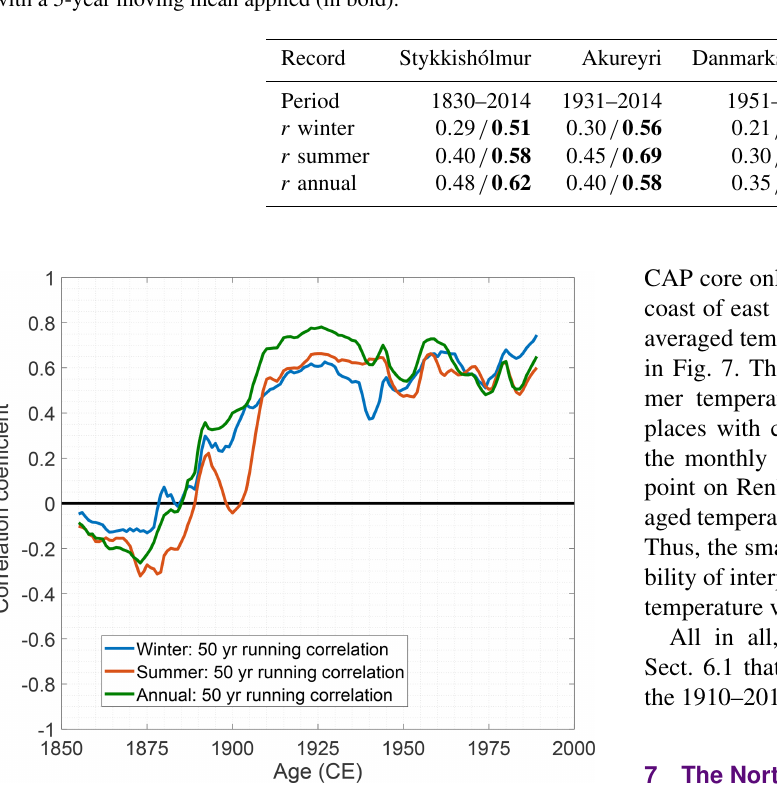
Figure 5. Running correlation of 50 years between the Stykkishól- mur temperature and the δ 18 O stack for winter (blue), summer (red) and annual averages (green). Both the δ 18 O and temperature data were first smoothed with a 5-year moving mean. Each year repre- sents the midpoint of the running